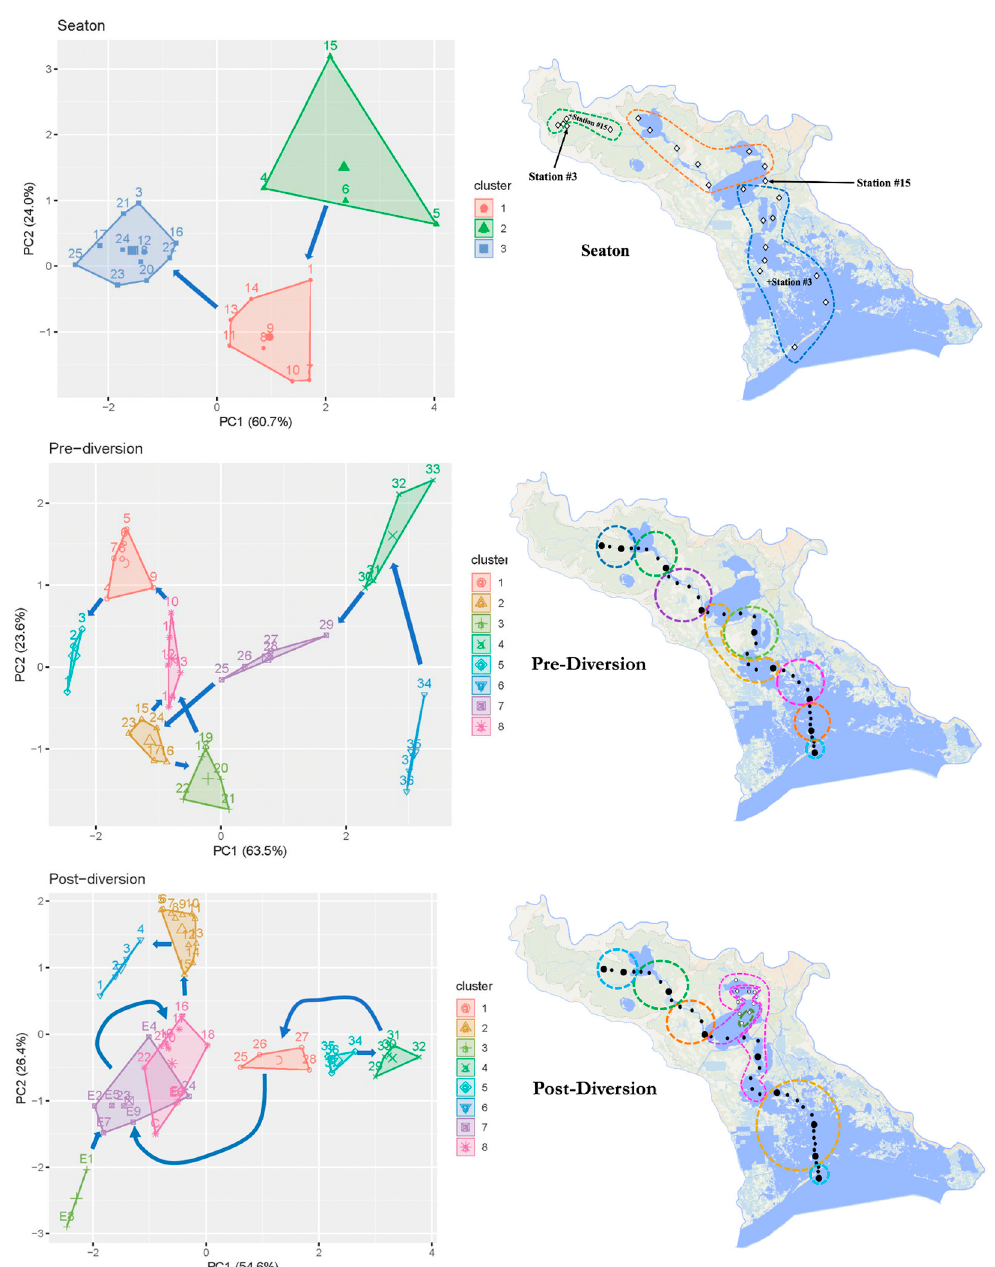
Figure 3. The k-means clustering of stations, across the three time periods: Seaton, Pre-diversion and Post-diversion. Arrows show how the clusters are hydrologically connected. Clusters for each case are shown on maps of the basin with sampling stations. Top row Seaton, middle row Pre-diversion, bottom row Post-diversion. These figures show that the statistical analysis captures both hydrological flow as well as nutrient